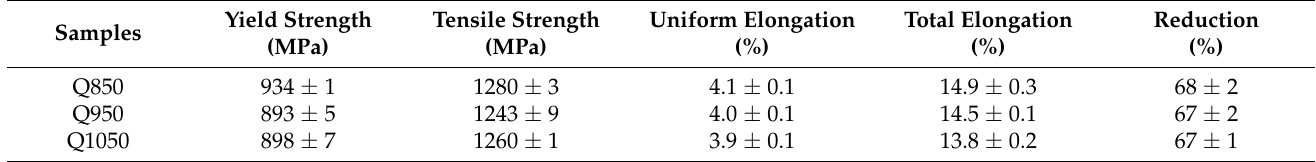
Table 1. Tensile properties of experimental samples with different austenitizing temperatures.